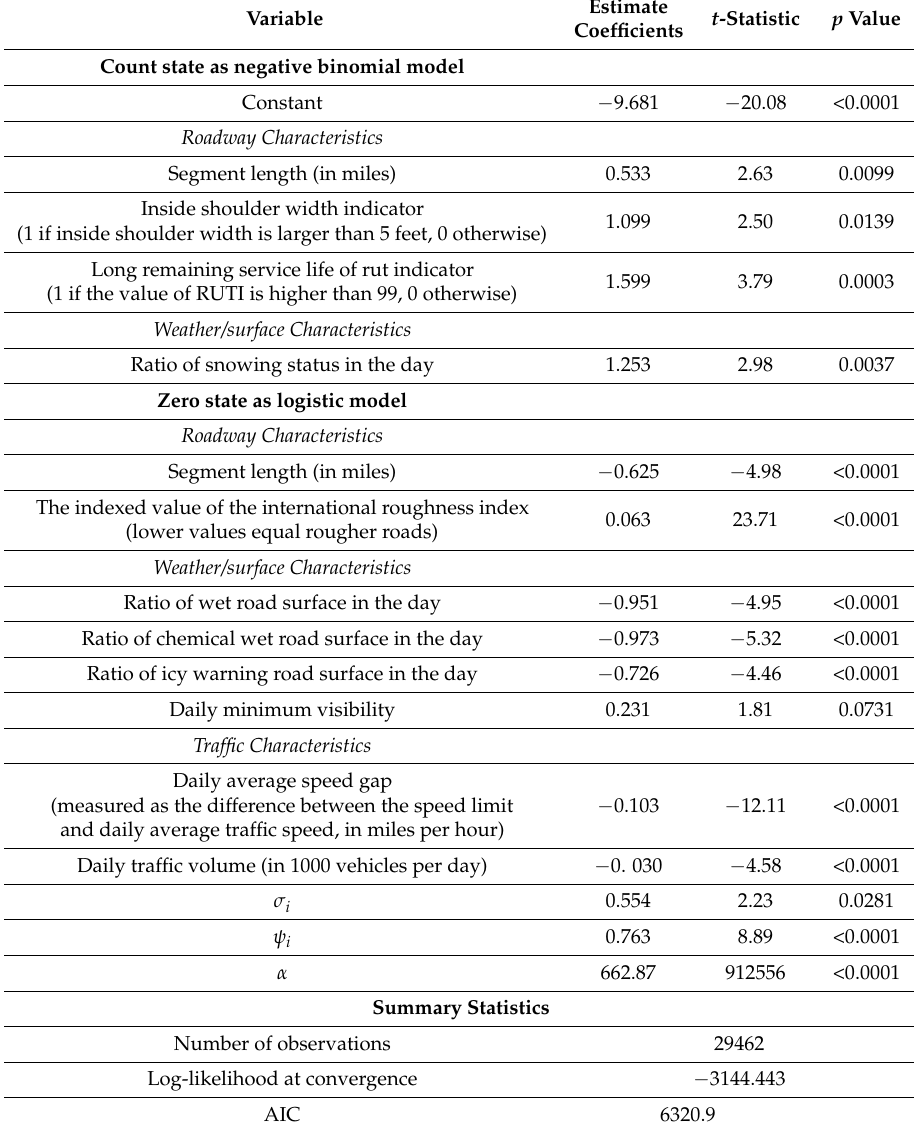
Table 2. Random effect hurdle negative binomial model estimation